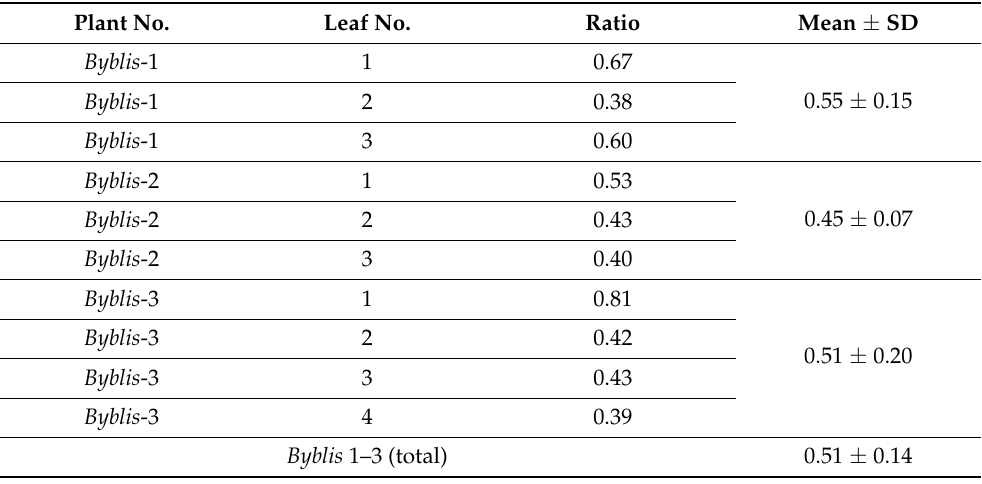
Table 1. Stalked gland densities measured on 10 leaves from three plants, indicated as ratios between the stalked gland numbers on areas identical in dimension on the upper and lower leaf surfaces. Plant No. Leaf No. Ratio Mean ± SD Byblis -1 1